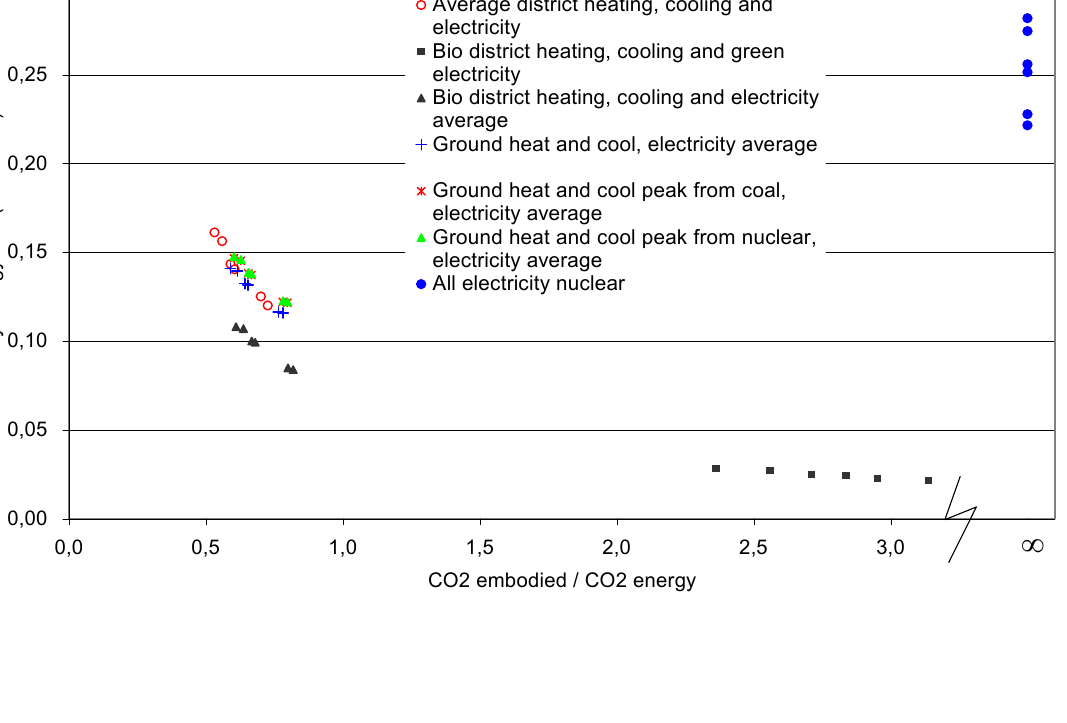
embodied corresponds to the 2 energy corresponds the 2